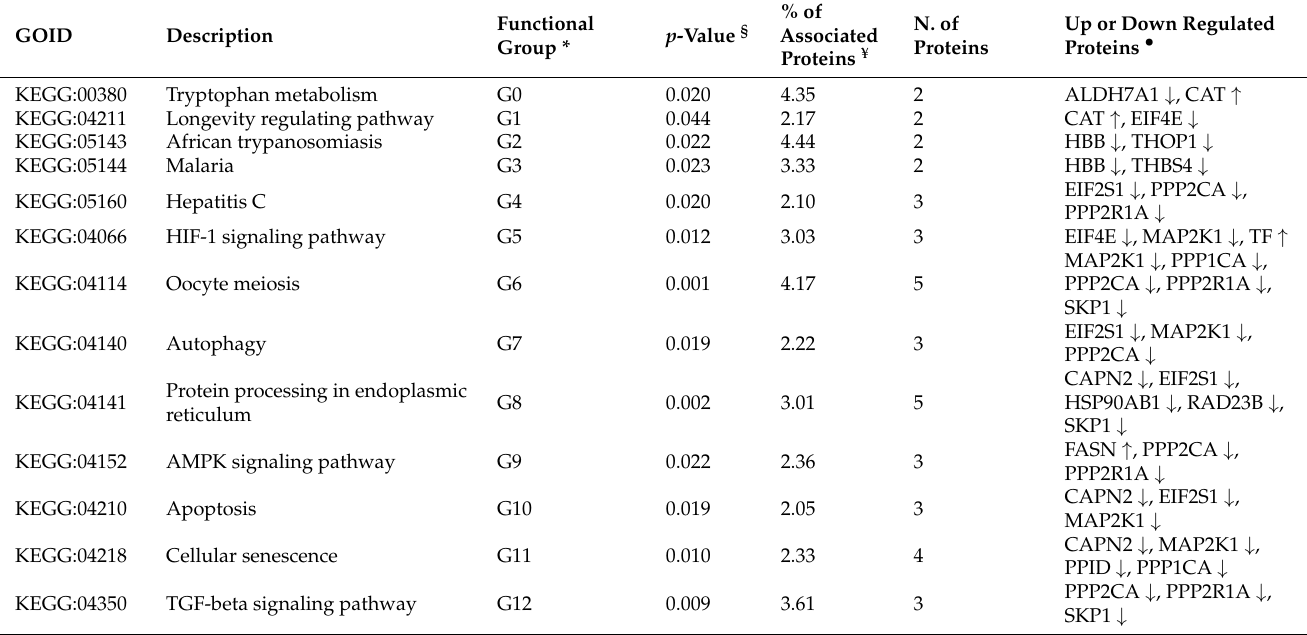
Table 3. KEGG pathway analysis of differential proteins in the goat breed